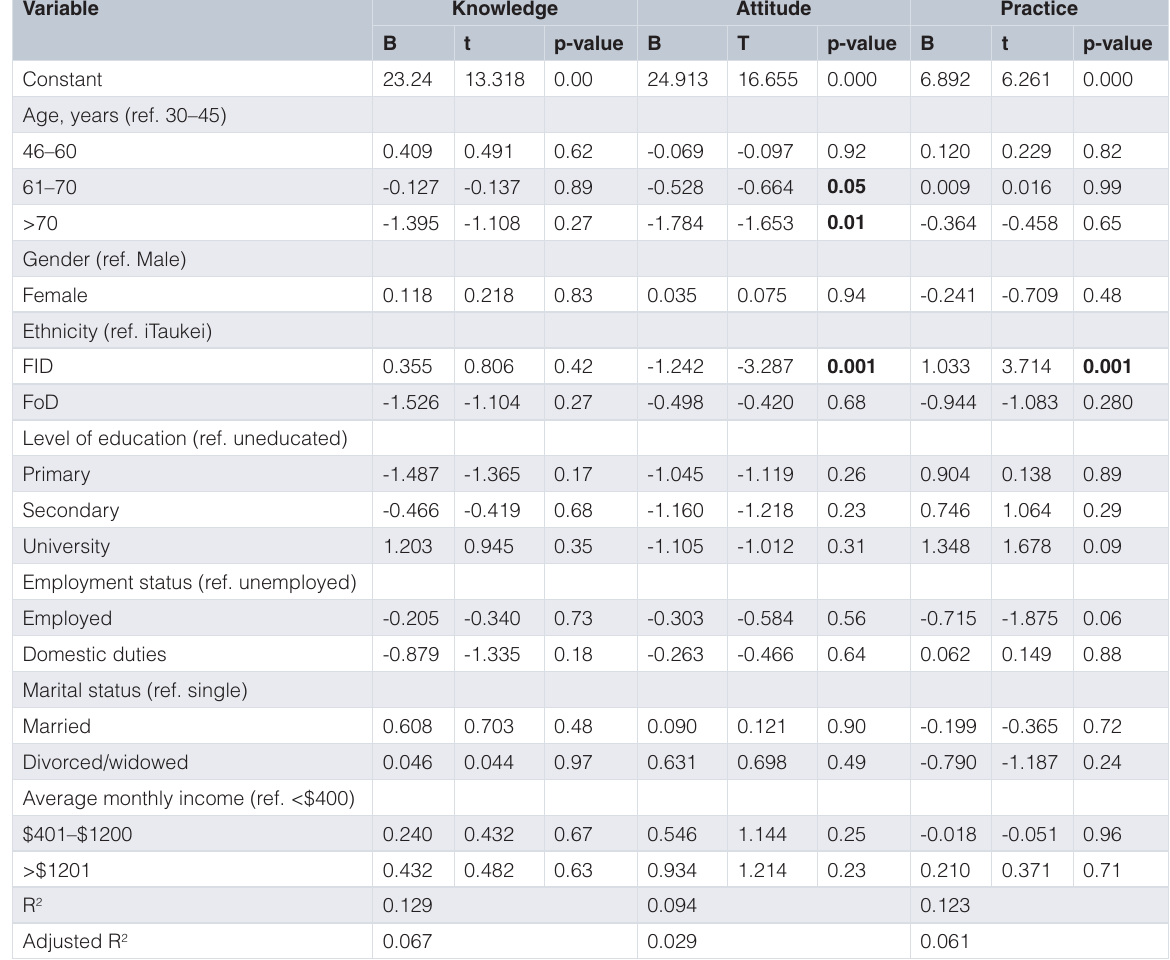
Table 4. Multiple linear regression tests on independent